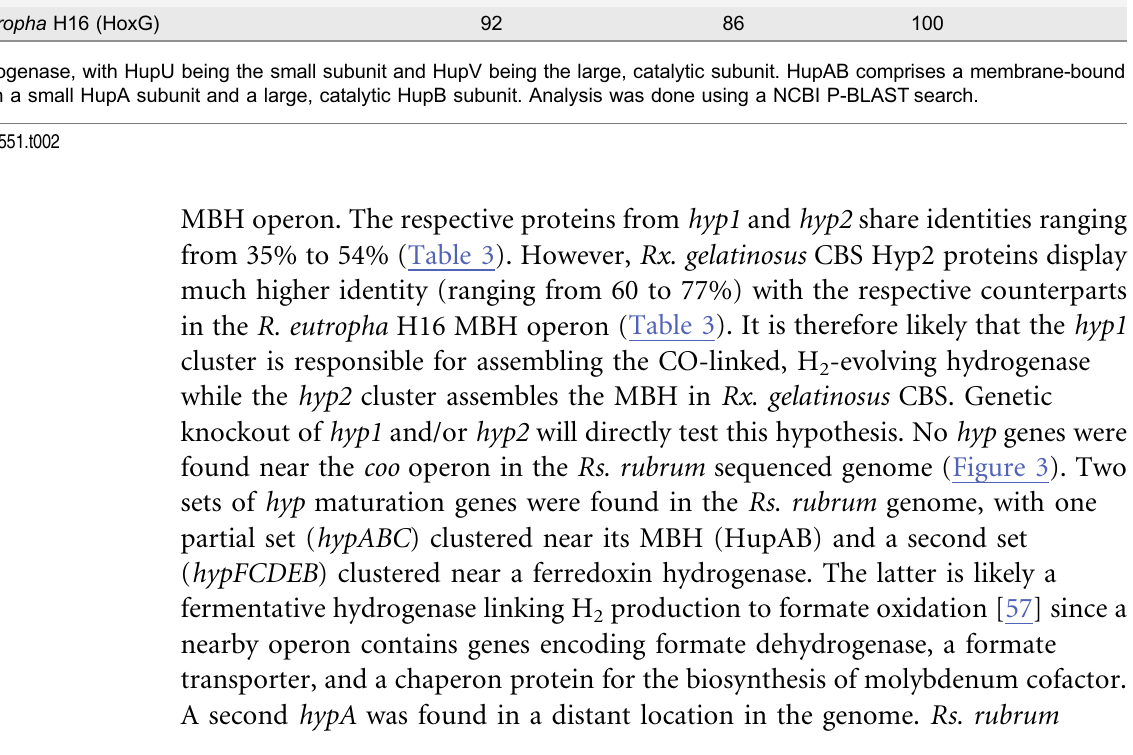
HupUV is a sensor hydrogenase, with HupU being the small subunit and HupV being the large, catalytic subunit. HupAB comprises a membrane-bound uptake hydrogenase with a small HupA subunit and a large, catalytic HupB subunit. Analysis was done using a NCBI P-BLAST search.